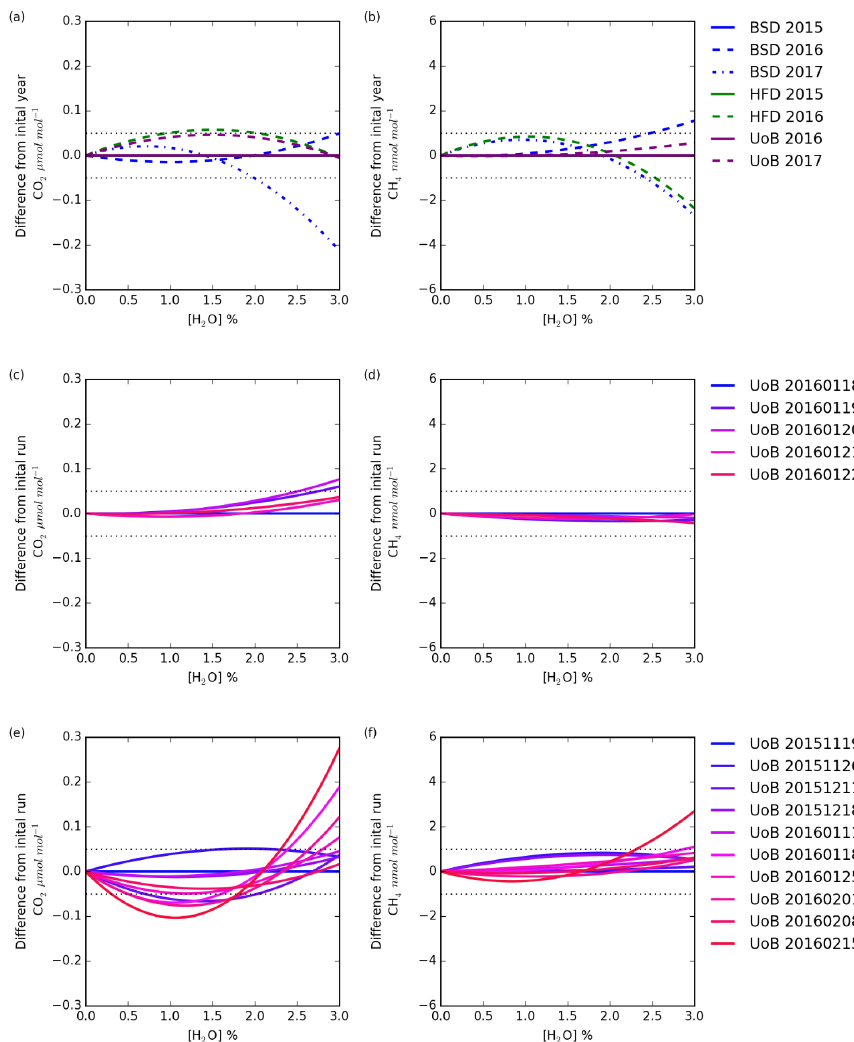
Figure 8. The change with water in the difference in CO 2 and CH 4 dry mole fraction between the first annual mean instrument-specific water correction and subsequent annual corrections (a, b) , the first individual water correction and subsequent daily corrections (c, d) , and the first individual water correction and subsequent weekly tests (e, f) . The daily and weekly tests were conducted using only the UoB instrument while the annual tests were conducted using all three